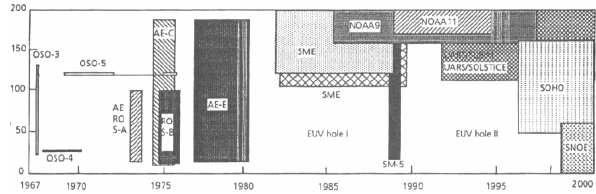
Figure 16. With x axis in time (years) and y axis in wave-